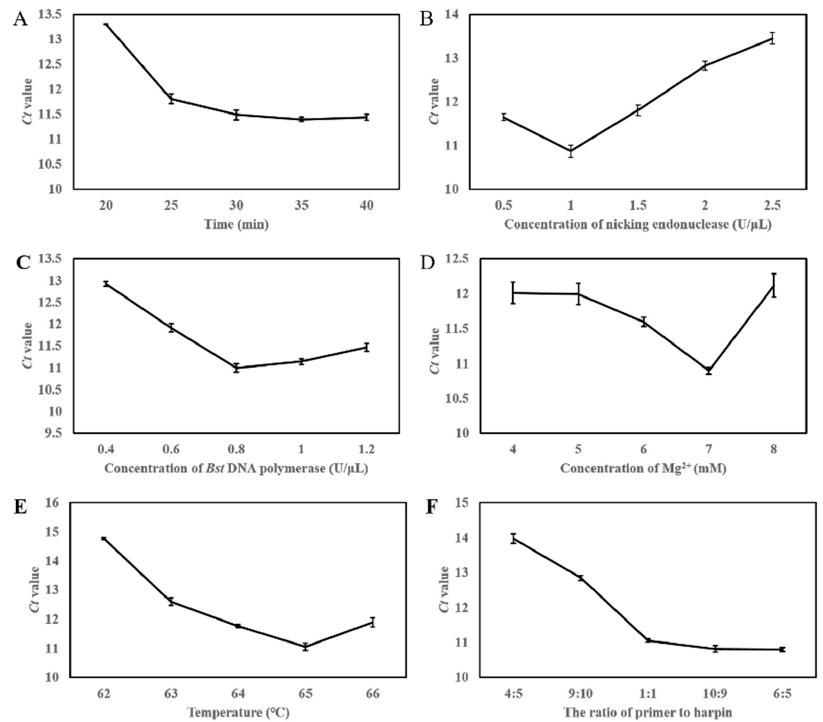
Figure 2. Optimization of the experimental conditions. ( A ) Incubation times of OTA and HP. ( B ) Concentrations of nicking endonuclease. ( C ) Concentrations of Bst DNA polymerase. ( D ) Mg 2+ concentrations. ( E ) Ratios of primer to HP. ( F ) Reaction temperatures.